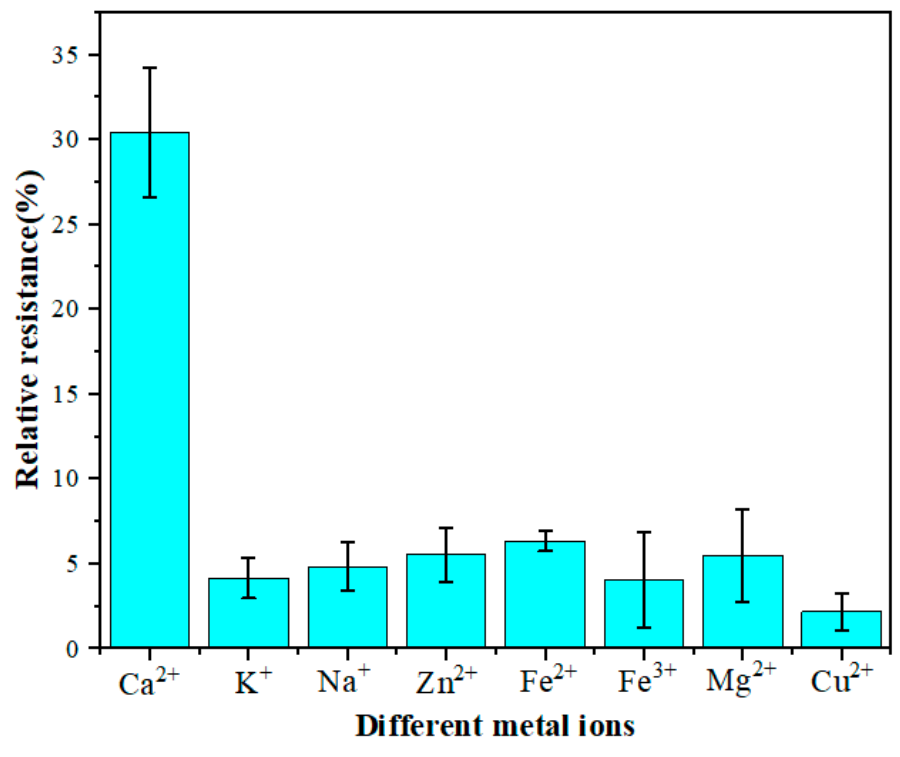
Figure 9. The relative resistance of GCE/NGR/AuNPs/Sub-DNAzyme duplex incubated in different 0.4 mM metal ion solutions (K + , Na + , Zn 2+ , Fe 2+ , Fe 3+ , Mg 2+ , and Cu 2+ ) (The error bars were determined in three duplicates).